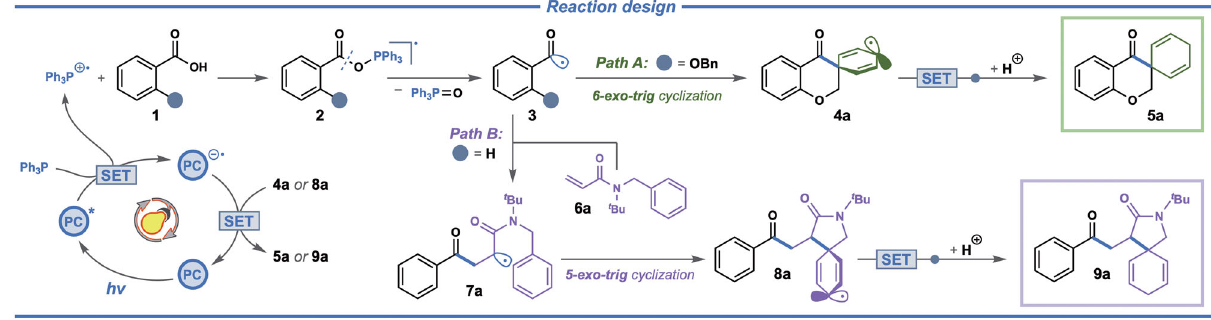
Fig. 2 Reaction design. Proposed photocatalytic cycle for intramolecular (Path A) and intermolecular (Path B) construction of spiro-compounds. Table 1 Optimization of the reaction conditions [a]